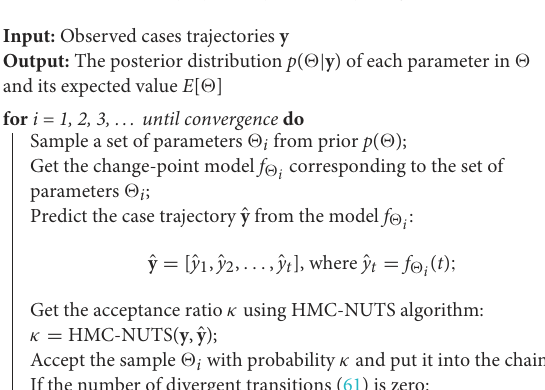
Algorithm 2. Change-point detection using HMC-NUTS